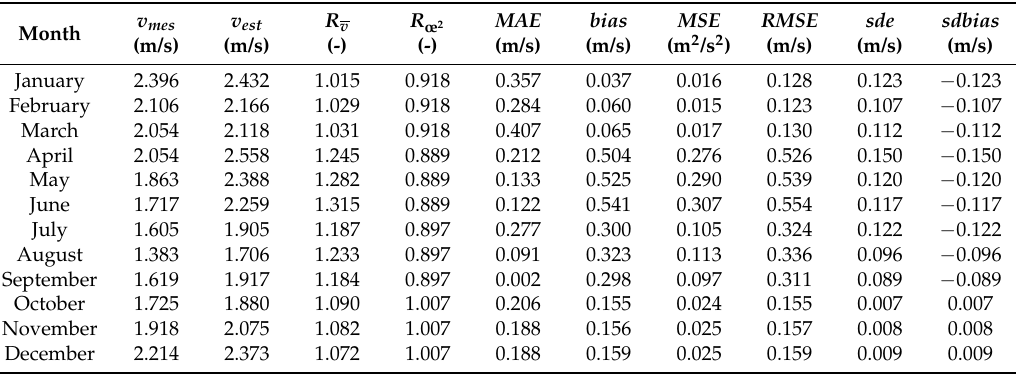
Table 4. Month-wise error estimation in the predicted wind speed of test year